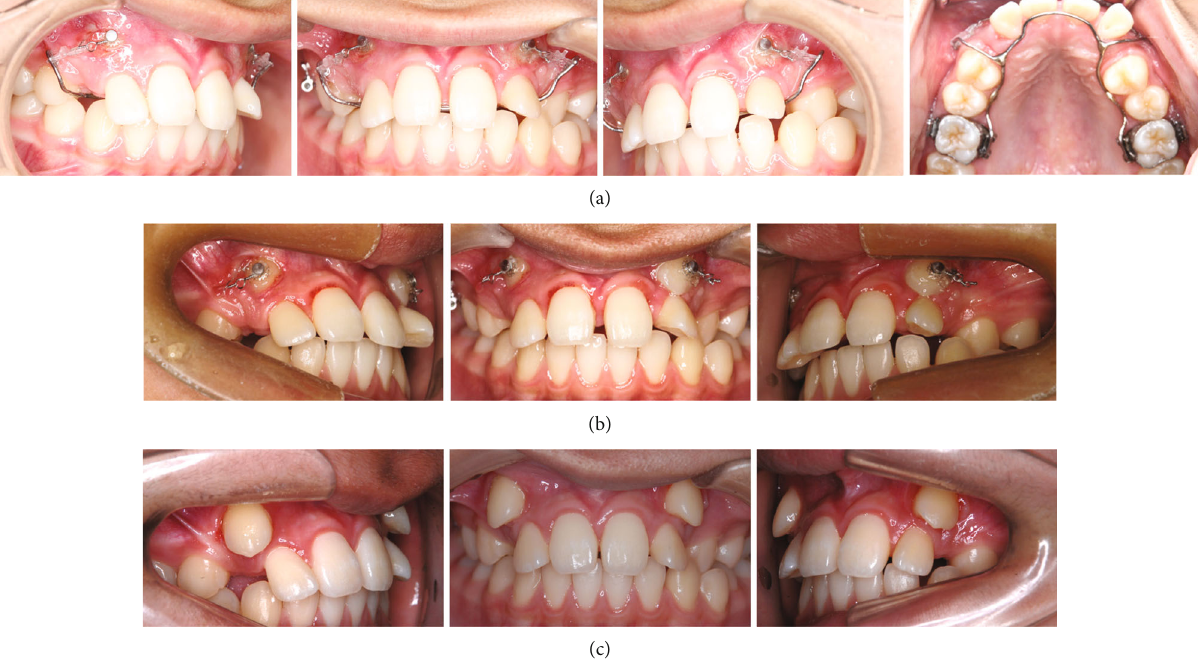
Figure 4: Treatment progress: (a) at the beginning of canine traction, (b) six months after canine traction, and (c) on completion of canine